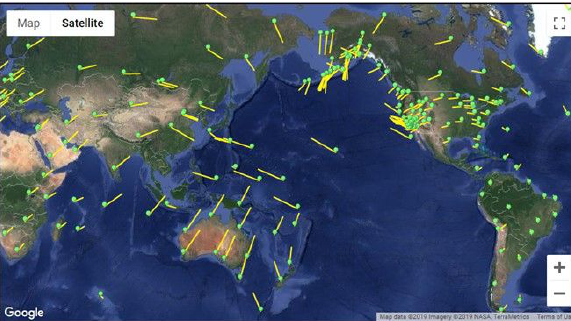
Figure 2: Location of the GPS domes considered by JPL. Image modi- fied after [19].